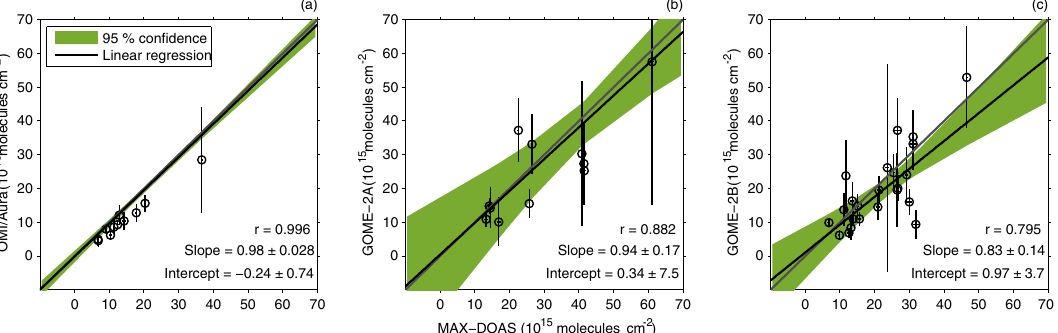
Figure 8. Scatter plots of the tropospheric NO 2 data pairs presented in Fig. 7. Ground-based observations are compared with OMI (a) , GOME-2A (b) and GOME-2B (c) overpass data. The grey and black lines stand for the y = x reference line and the error-weighted linear fit, respectively. The 95% confidence interval of the fitting is also shown (green area). The corresponding comparison statistics are presented in the first data column of Table